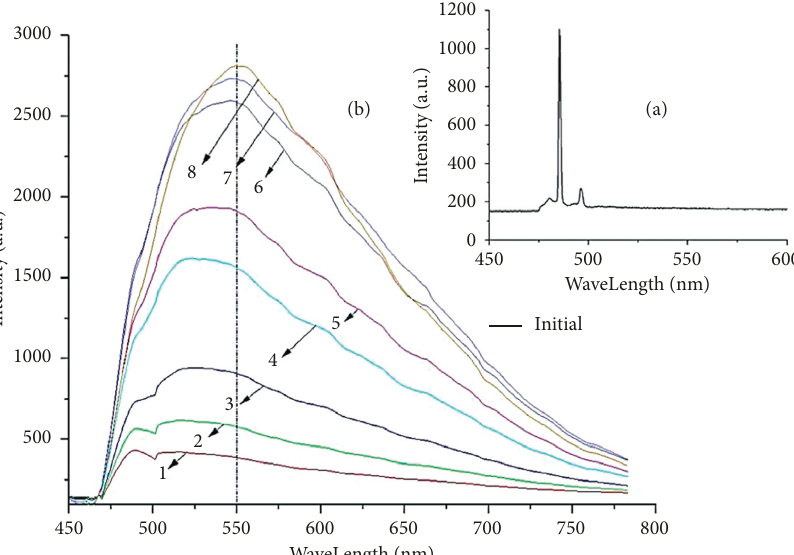
Figure 1: Photoluminescence spectra of PS samples obtained at J doped with carbon at different delay times of the moment of registration relative to the laser pulse maximum t d , µ s: 0 (1), 5 (2), 10 (3), 15 (4), 20 (5), 25 (6), 30 (7), and 35 (8) µ Figure 1(a), the PL spectra of the initial nanoporous silicon